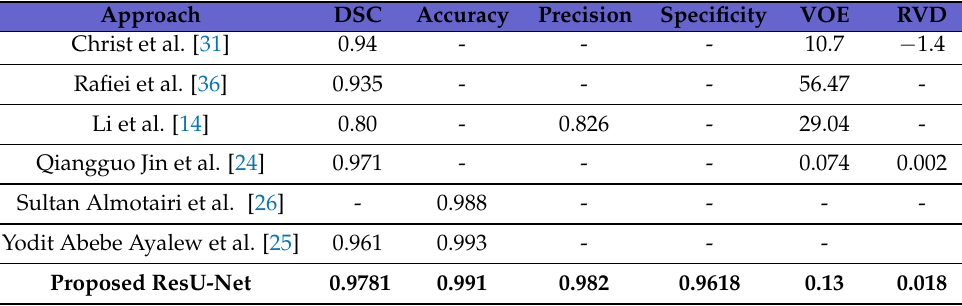
Table 4. Result comparison of ResU-Net based liver segmentation with state-of-art techniques.